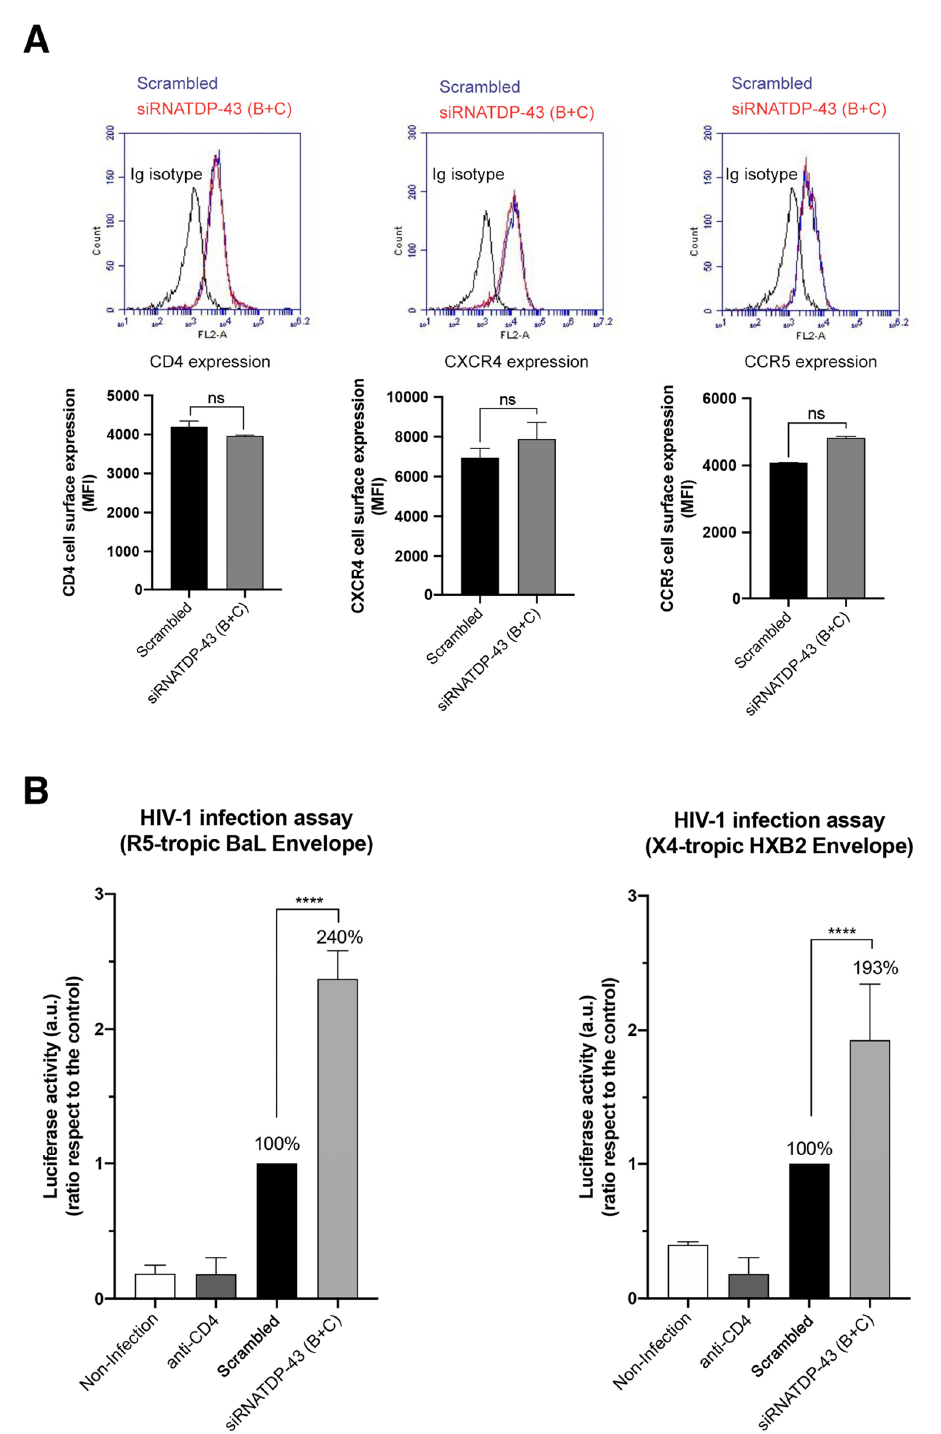
Figure 5. Effect of TDP-43 silencing on cell-surface expression of HIV-1 receptors and on viral infection. ( A ) Flow cytometry analysis of CD4, CXCR4 and CCR5 cell-surface expression in CEM.NKR-CCR5 cells where endogenous TDP-43 were silenced by using specific siRNA oligos (B + C) and compared to scrambled control condition (1 µ M of total mix oligos and of scrambled oligo). Data are mean ± S.E.M. of four independent experiments carried out in triplicate. Top, representative flow chart with the histograms below where the replicates are shown, indicating CD4, CXCR4 and CCR5 expression, under any experimental condition. Ig isotype control is shown. When indicated, n.s. stands for non- significative, value for Student’s t -test. ( B ) Effect of TDP-43 silencing in permissive CEM.NKR-CCR5 cells on HIV-1 infection. siRNA-TDP-43 (B + C)-treated or scrambled control cells were infected